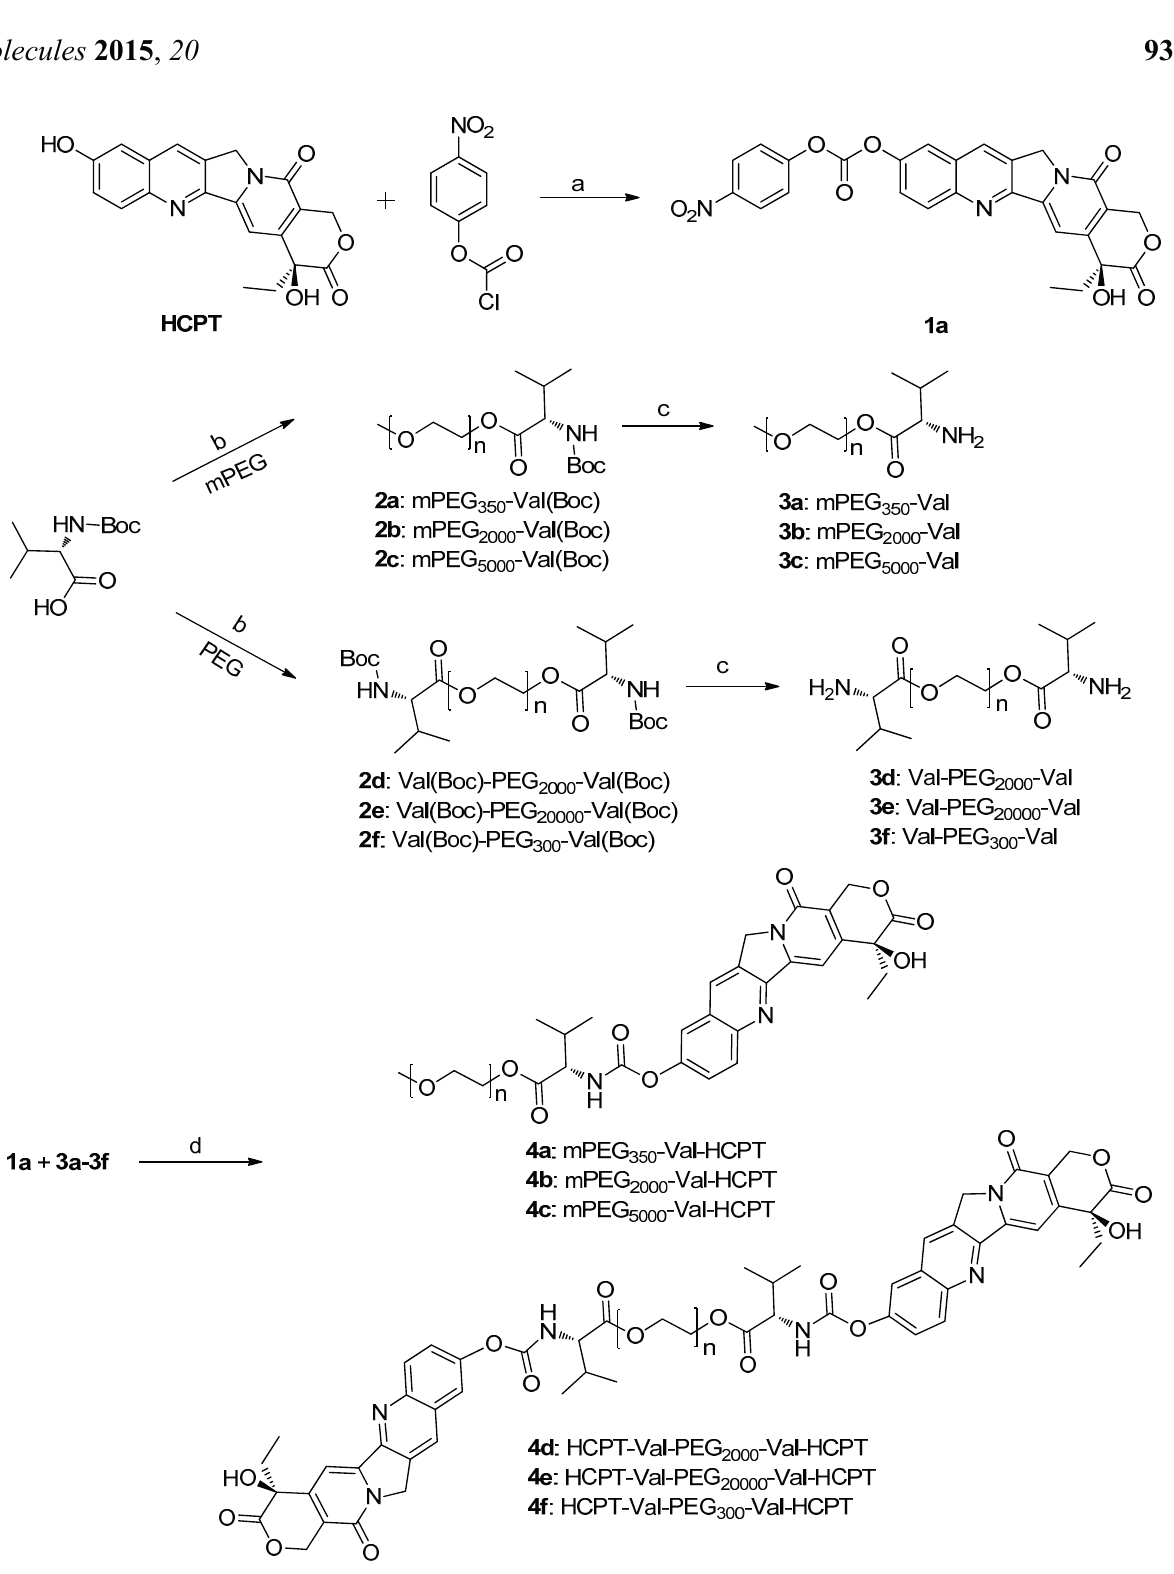
Scheme 1. Synthesis of conjugates 4a – 4f